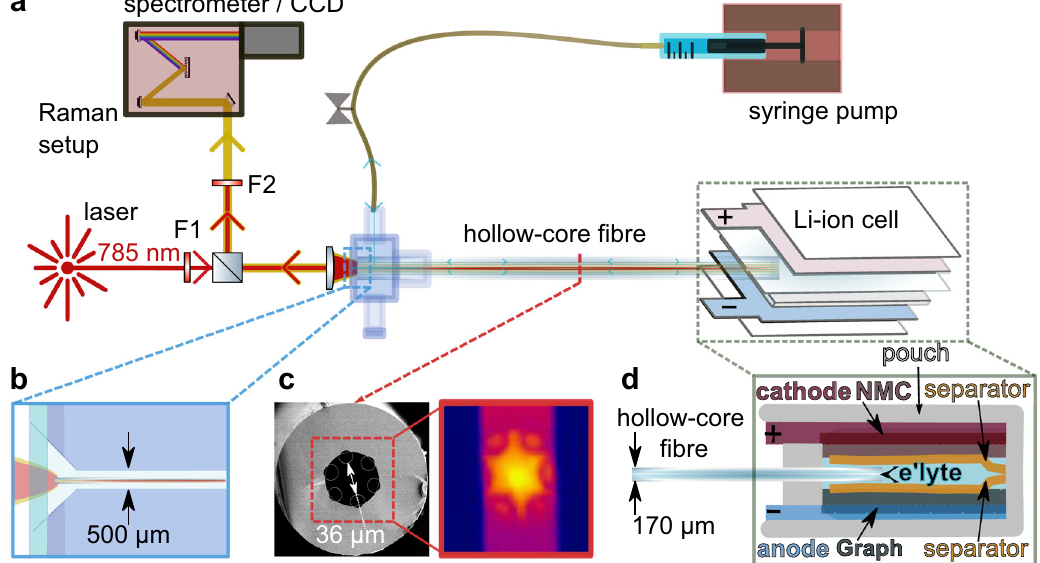
Fig. 1 Hollow-core fi bre-coupled Raman analysis of a Li-ion pouch cell. a , b Continuous- wave laser light (785 nm) is fi ltered and launched into the core of a single-ring HC- fi bre. The proximate fi bre facet is embedded in a micro fl uidic chamber with a sapphire window ( b ) and connected to a syringe pump for on-demand sampling/infusion. The distal fi bre facet is embedded in the pouch cell under study. The backscattered Raman signal generated within the HC- fi bre re fl ects off a 50:50 beam-splitter, fi ltered and analysed by a spectrometer. F1, bandpass fi lter; F2, notch fi lter. c SEM image of the hollow-core fi bre with an outer diameter of 174 µ m and a core diameter of 36 µ m (measured between the inner capillaries (see Supplementary Fig. 1). The right-hand image shows the Raman signal detected by the spectrometer CCD (Charge Coupled Device) camera. d Schematic indicating the electrodes, separator, and fi bre probe arrangements within the pouch cell (not to scale — for details, see Supplementary Figs. 3 and image of the generated Raman light (right-hand image in Fig. 1c) shows that most of the Raman light is generated and guided within the hollow fi bre core. After each optical measurement, the electrolyte sample is injected back into the pouch cell. Avoiding any cell perturbations leads to single sampling intervals that take 22 min (ca. 4% of the full discharging time at C/10 C-rate). Sampling was repeated periodically to monitor the electrolyte takes more than 10 h).